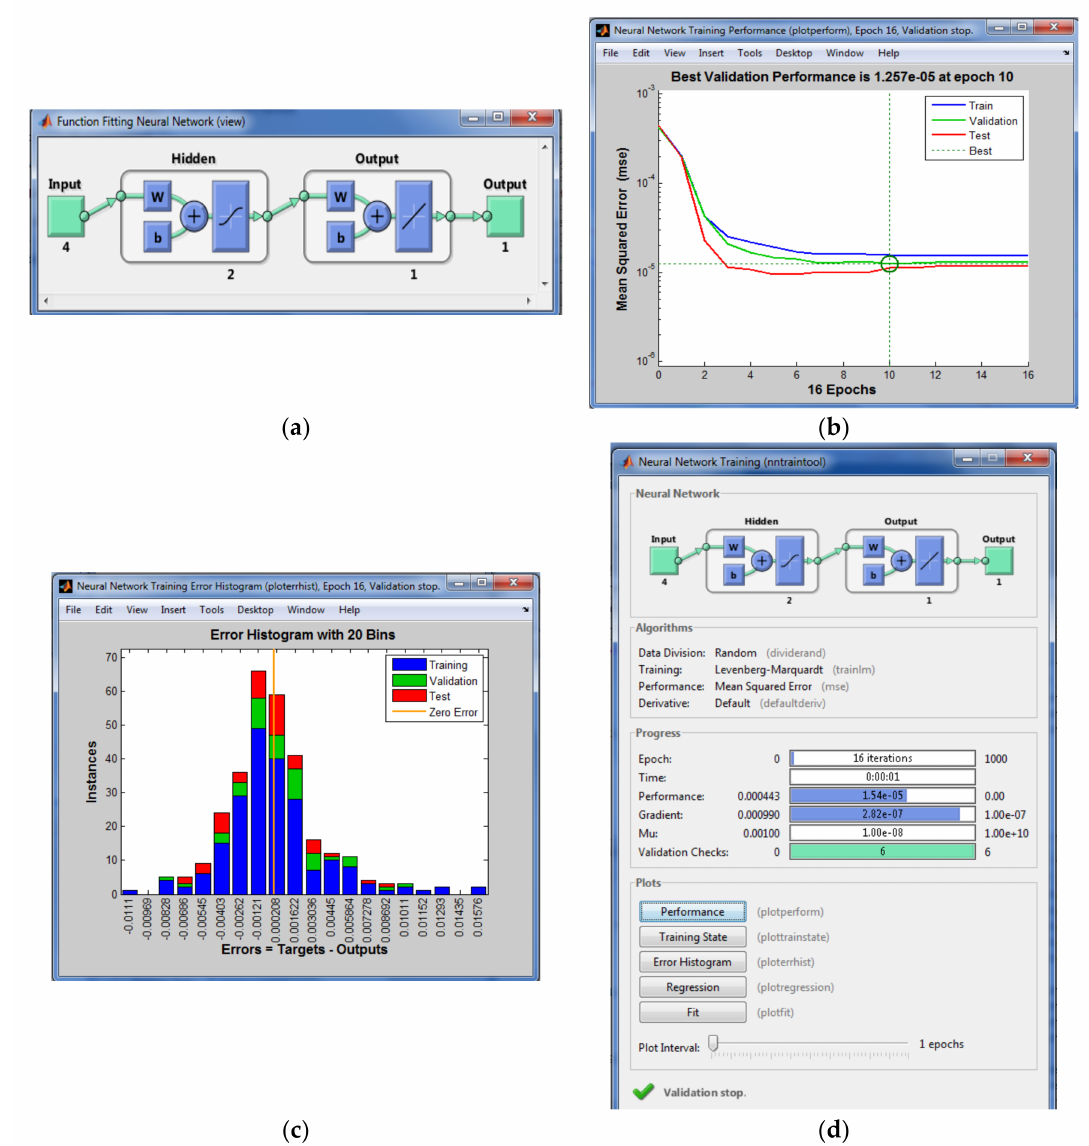
Figure 7. ( a ) Design of the ANN scheme; ( b ) mean square error (MSE); ( c ) error histogram